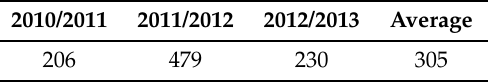
Table 1. The total produced energy (GWh) per year.